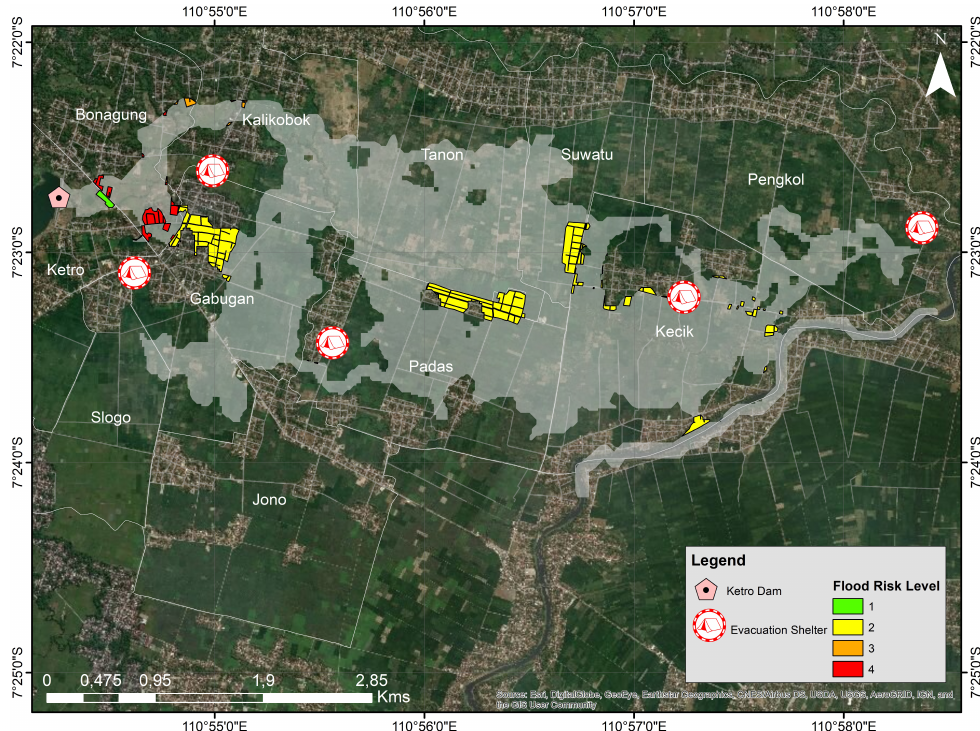
Figure 17. Final map of the FRL values for each location